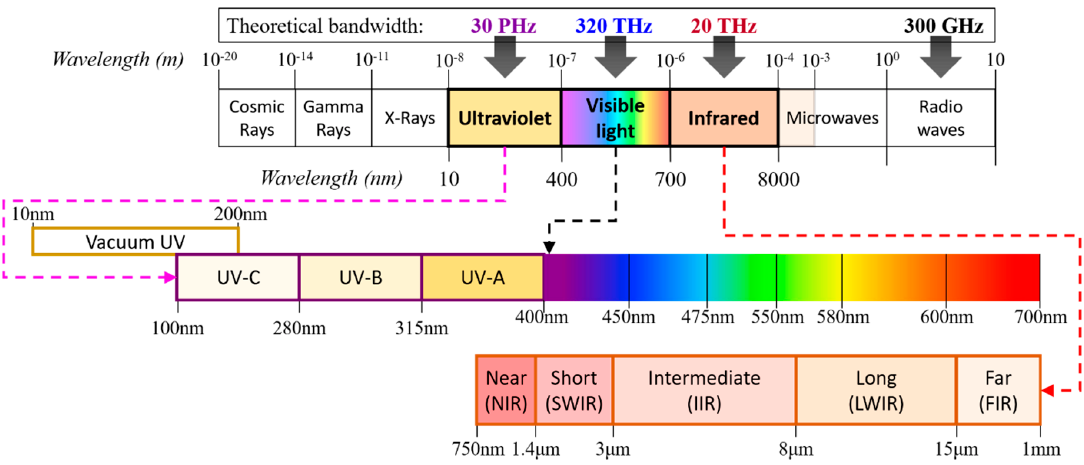
Figure 2. The VLC and IRC are generally considered for short-range indoor applications, while FSO (using the IR band) and UVC (using the C band) are predominantly employed for medium-long range outdoor environments. Note that FSO can also use the visible band for short to medium range transmissions.